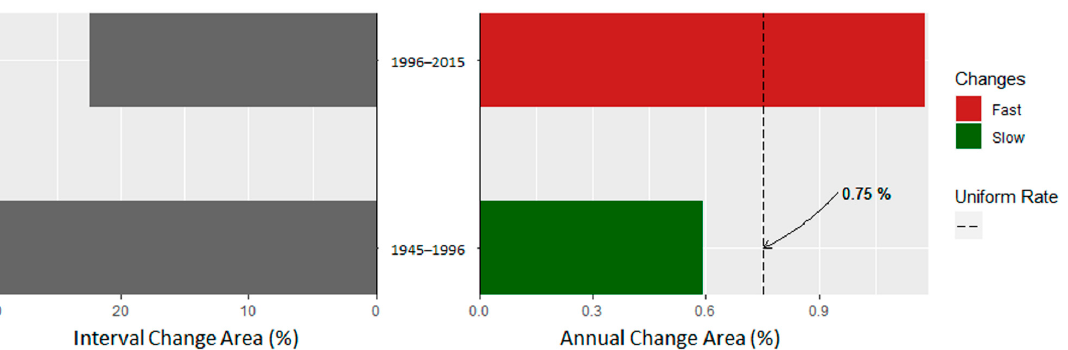
Figure 5. Interval level intensity analysis in the study area for the periods 1945–1996 and 1996–2015, for the total change area in each period (left plot) and the rate of change for each period (right plot). The vertical, dashed line at the right plot represents the hypothesized uniform intensity for the total period (1945–2015) and the periods with a bar extending beyond this line are considered as changing fast (red color), while those with a bar before that line are considered as changing slow (green color).